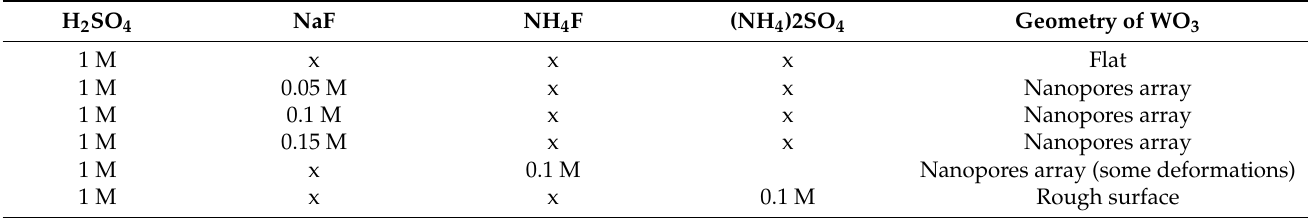
Figure 4. SEM micrographs showing the process of the formation of WO 3 nanopores into W foil during anodization in 1 M H 2 SO 4 solution containing various concentrations of NaF: ( a ) 0.05 M; ( b ) 0.1 M; and ( c ) 0.15 M. Table 1. Detailed list of tested anodization